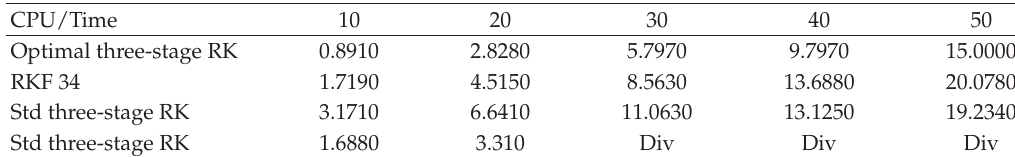
Table 5: Comparison of CPU time among the optimal three-stage RK, RKF 34, and standard three-stage RK with Δ t (cid:6) 0 . 0005 and Δ t (cid:6) 0 . 001, respectively.